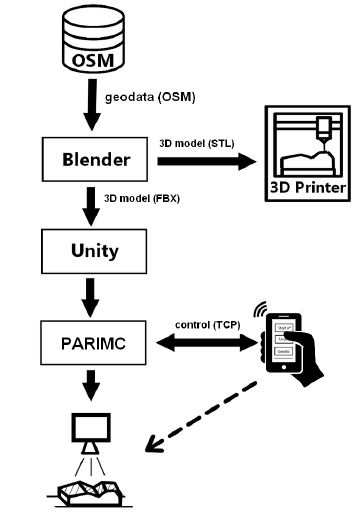
Figure 1. Representation of the architecture of the system and data